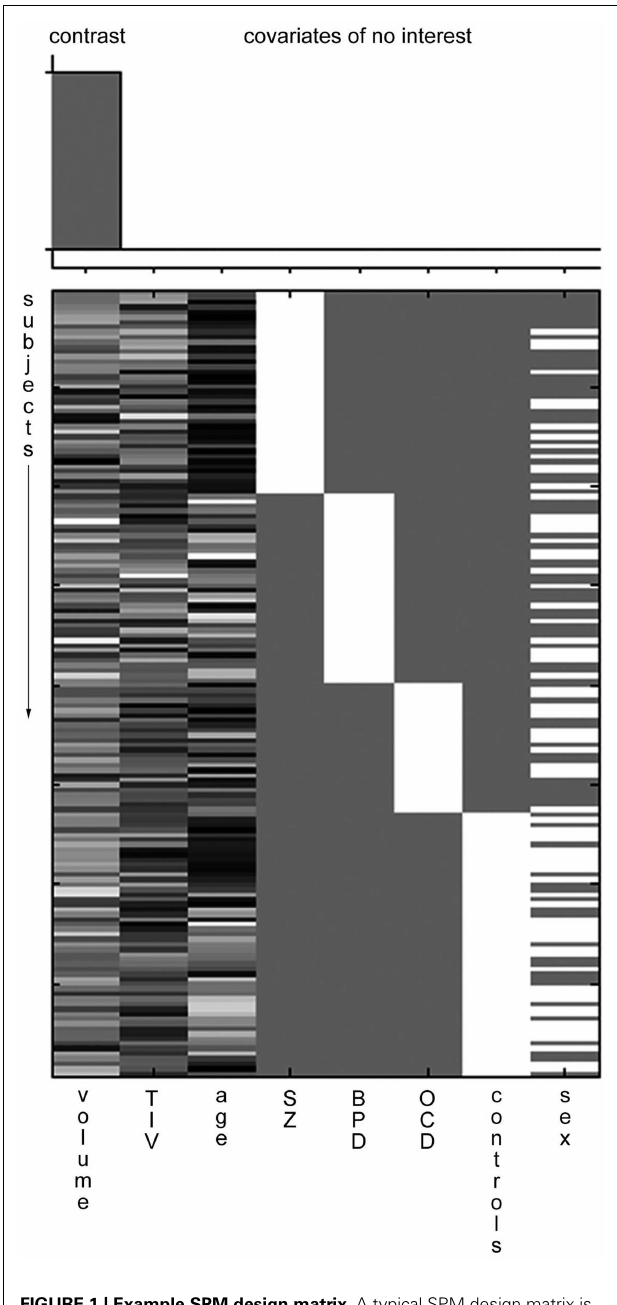
FIGURE 1 | Example SPM design matrix . A typical SPM design matrix is shown.The volume column is the main effect contrast, total intracranial volume (TIV), age, diagnostic group (SZ, schizophrenia; BPD, bipolar affective disorder; OCD, obsessive compulsive disorder), and sex are included as covariates of no